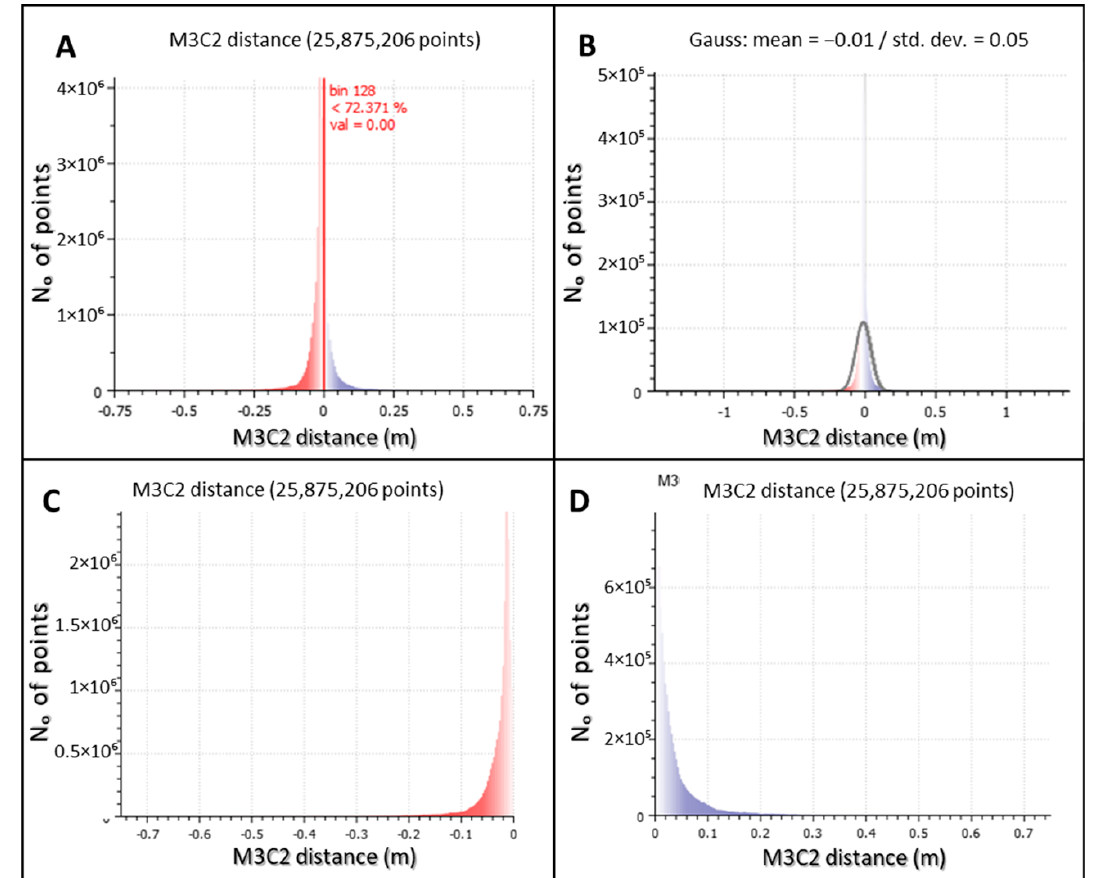
Figure 12. Histogram of all STCs detected by M3C2 algorithm ( A ); Gaussian distribution of all STCs detected by M3C2 algorithm ( B ); negative STCs (erosion) detected by M3C2 algorithm ( C ); positive STCs (accumulation) detected by M3C2 algorithm ( D ).